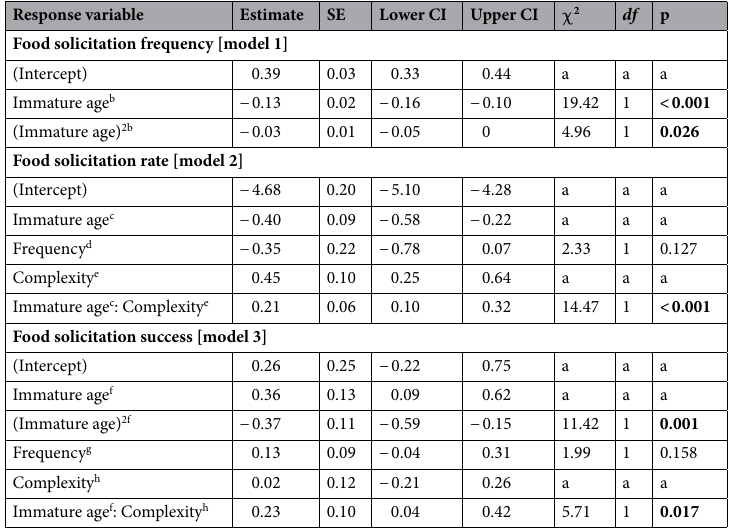
Table 1. Effects on all three models. Estimates and standard errors (retrieved from the summary output of the GLMM with a binomial error distribution), chi-square ( χ 2 ), confidence intervals (95% CI) [lower, upper] degrees of freedom, p values (obtained via a likelihood ratio test by dropping each of the fixed effects one at a time and comparing the reduced model to the complete model) for all three models. Significant values are in bold. a Not shown, as having limited interpretation. b z-transformed to a mean of zero and SD of one; mean and SD of the untransformed variable were 4.95 and 3.34 processing steps, respectively. c z-transformed to a mean of zero and SD of one; mean and SD of the untransformed variable were 4.07 and 2.46 processing steps, respectively. d z-transformed to a mean of zero and SD of one; mean and SD of the untransformed variable were 0.05 and 0.07 processing steps, respectively. e z-transformed to a mean of zero and SD of one; mean and SD of the untransformed variable were 1.62 and 1.25 processing steps, respectively. f z-transformed to a mean of zero and SD of one; mean and SD of the untransformed variable were 3.66 and 2.15 years, respectively. g z-transformed to a mean of zero and SD of one; mean and SD of the untransformed variable were 0.05 and 0.06, respectively. h z-transformed to a mean of zero and SD of one; mean and SD of the untransformed variable were 2.45 and 1.31 processing steps,